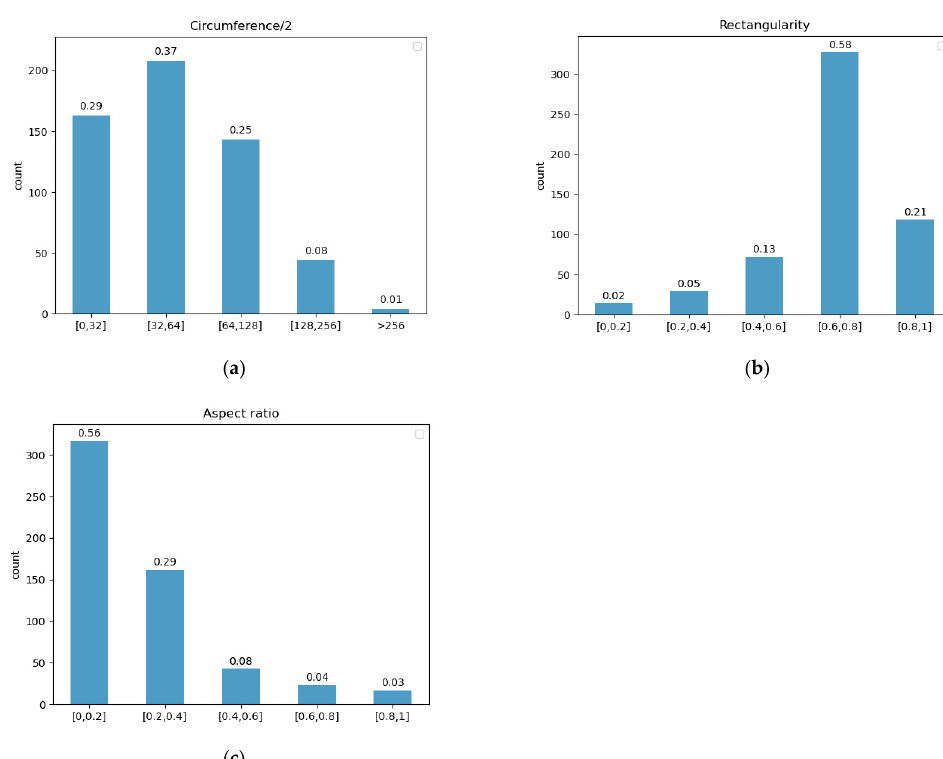
Figure 2. View of the results for geometric feature statistics: ( a ) semi-perimeter statistics for marine aquaculture areas; ( b ) rectangularity statistics for marine aquaculture areas; ( c ) aspect ratio statistics for marine aquaculture areas.